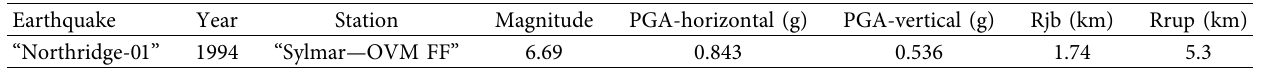
Table 4: Ground motion.